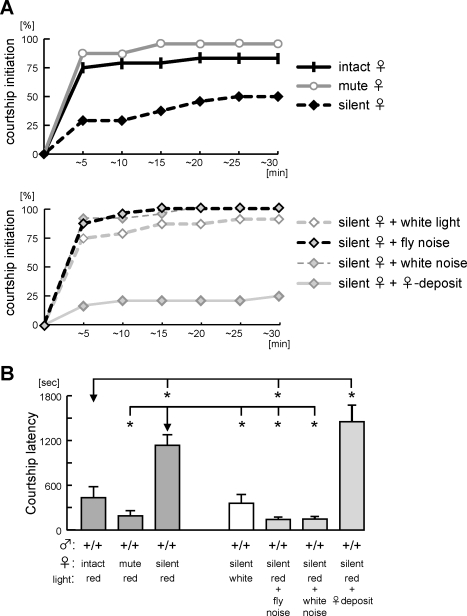
Courtship is stimulated by the active movement of the target female.Wild-type males were paired with the indicated type of female. (A) Courtship initiation was assayed for wild-type, paired with a wingless (“mute”) or a decapitated (“silent”) wild-type female (upper panel) or a “silent” female and additional putative stimulatory cues (lower panel). (B) Mean values of courtship latency in each courtship condition. Mechanosensory stimulus, not excess amounts of female deposits, stimulates courtship initiation. Statistical significance is represented for comparison to the data indicated by each arrow (*P<0.05). Behavior was recorded in a rectangular chamber with dimensions 70 mm×10 mm×7 mm.